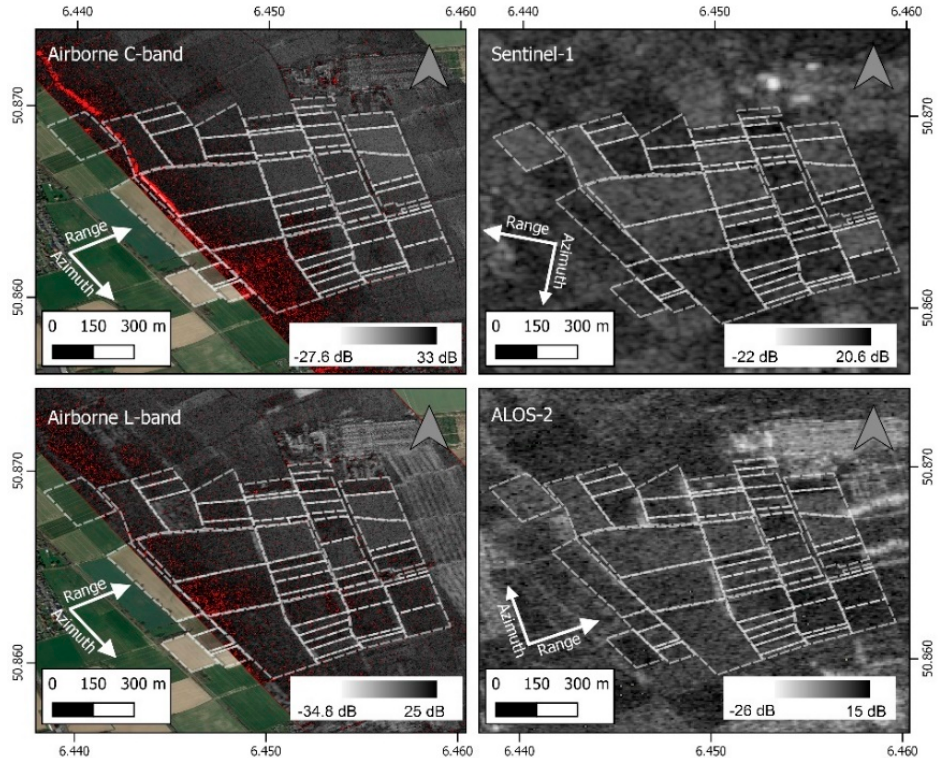
Figure 4. Comparison of airborne C- and L-band data with Sentinel-1 and ALOS-2 over the Selhausen test site for the 21/22 June.